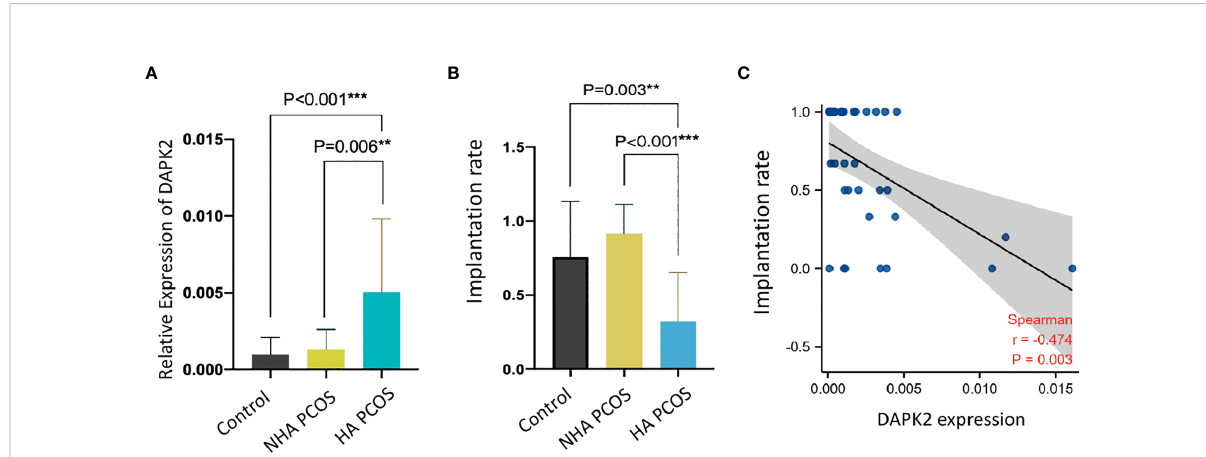
FIGURE 6 Validation of DAPK2 expression and embryo implantation rate with clinical data. (A) DAPK2 mRNA expression is signi fi cantly upregulated in HA PCOS compared with NHA PCOS ( p =0.006) and controls ( p <0.001). (B) the embryo implantation rate is signi fi cantly lower in HA PCOS compared with NHA PCOS ( p =0.003) and controls ( p <0.001). (C) DAPK2 expression was negatively related with embryo implantation rate. ** p <0.01, *** p <